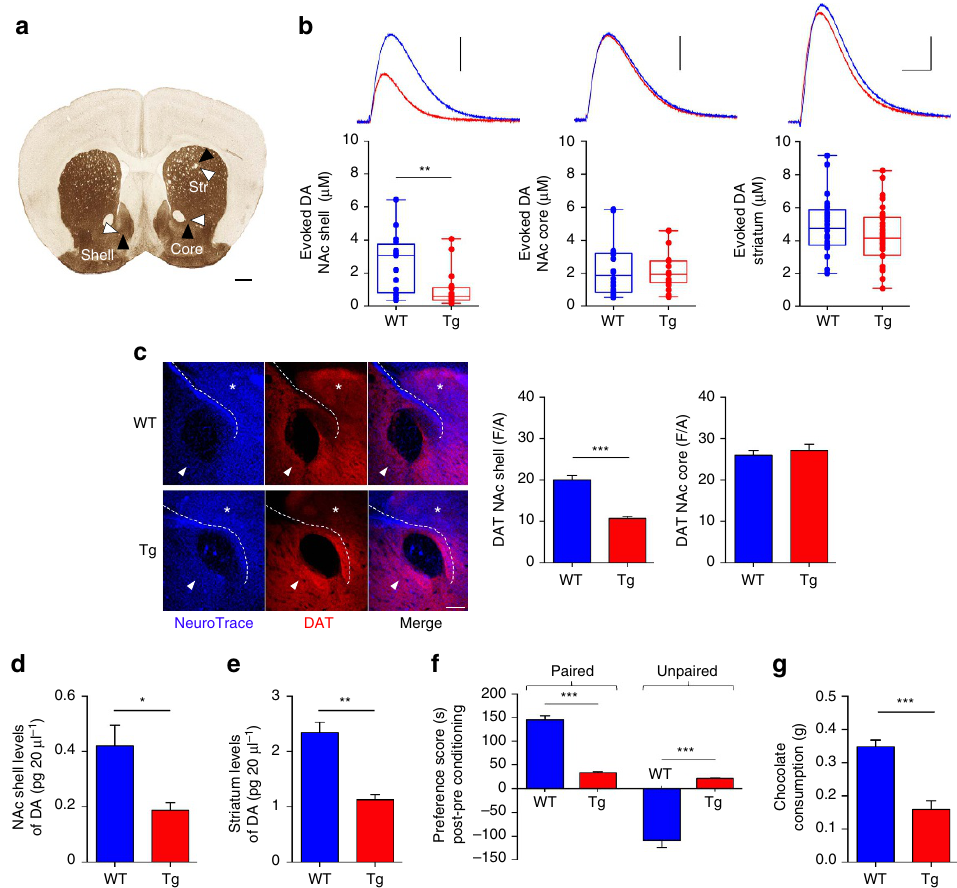
Figure 3 | Reduced DA outflow in the NAc shell and deficits in mesolimbic reward processing in 6-month-old Tg2576 mice. ( a ) Summary of stimulating (black arrowheads) and recording electrode (white arrowheads) placements during amperometric measurements of evoked DA in the NAc (Shell, Core) and striatum (Str; scale bar, 500 m m). ( b ) Evoked DA concentration in the indicated areas ( n ¼ 16–25 slices from 6–8 WT mice, 18–43 slices from 6–10 Tg2576 mice) and example traces from 6-month-old WT and Tg2576 mice (vertical scale bars: NAc shell and core, 50 pA; striatum, 100 pA; horizontal scale bar, 250ms) recorded with a carbon fibre electrode of equal calibration (two-tailed unpaired t -test ** P ¼ 0.004). In this and other figures, in box-and- whisker plots the centre lines denote medians, edges represent upper and lower quartiles and whiskers show minimum and maximum values. Points are individual experiments. ( c ) Z-stack double immunofluorescent labelling for NeuroTrace and DAT in NAc coronal sections showing the NAc shell (asterisk) and core (arrowhead; scale bar, 200 m m). Bar plots show densitometric values of DAT levels in 6-month-old mice ( n ¼ 3 per genotype, 4 sections per animal; two-tailed unpaired t -test *** P ¼ 1.00 (cid:3) 10 (cid:2) 7 ). ( d , e ) Microdialysis measurements of DA outflow in the NAc shell ( d ) and dorsal striatum ( e ) in 6-month-old mice ( d : n ¼ 6 WT and 5 Tg2576; one-way ANOVA: F 1,9 ¼ 5.138, * P ¼ 0.049; e : n ¼ 4 WT and 5 Tg2576; one-way ANOVA: F 1,7 ¼ 13.067, ** P ¼ 0.009). ( f ) Chocolate-induced place preference in 6-month-old mice ( n ¼ 5 mice per genotype) showing average time spent in paired and unpaired chambers in post-conditioning session, minus the time spent in the same chambers during the pre-conditioning session of a CPP test (two-way repeated measures ANOVA: chamber, F 1,8 ¼ 280.76, P o 1.00 (cid:3) 10 (cid:2) 4 ; chamber (cid:3) genotype, F 1,8 ¼ 231.34, P o 1.00 (cid:3) 10 (cid:2) 4 ; genotype, F 1,8 ¼ 0.84, P ¼